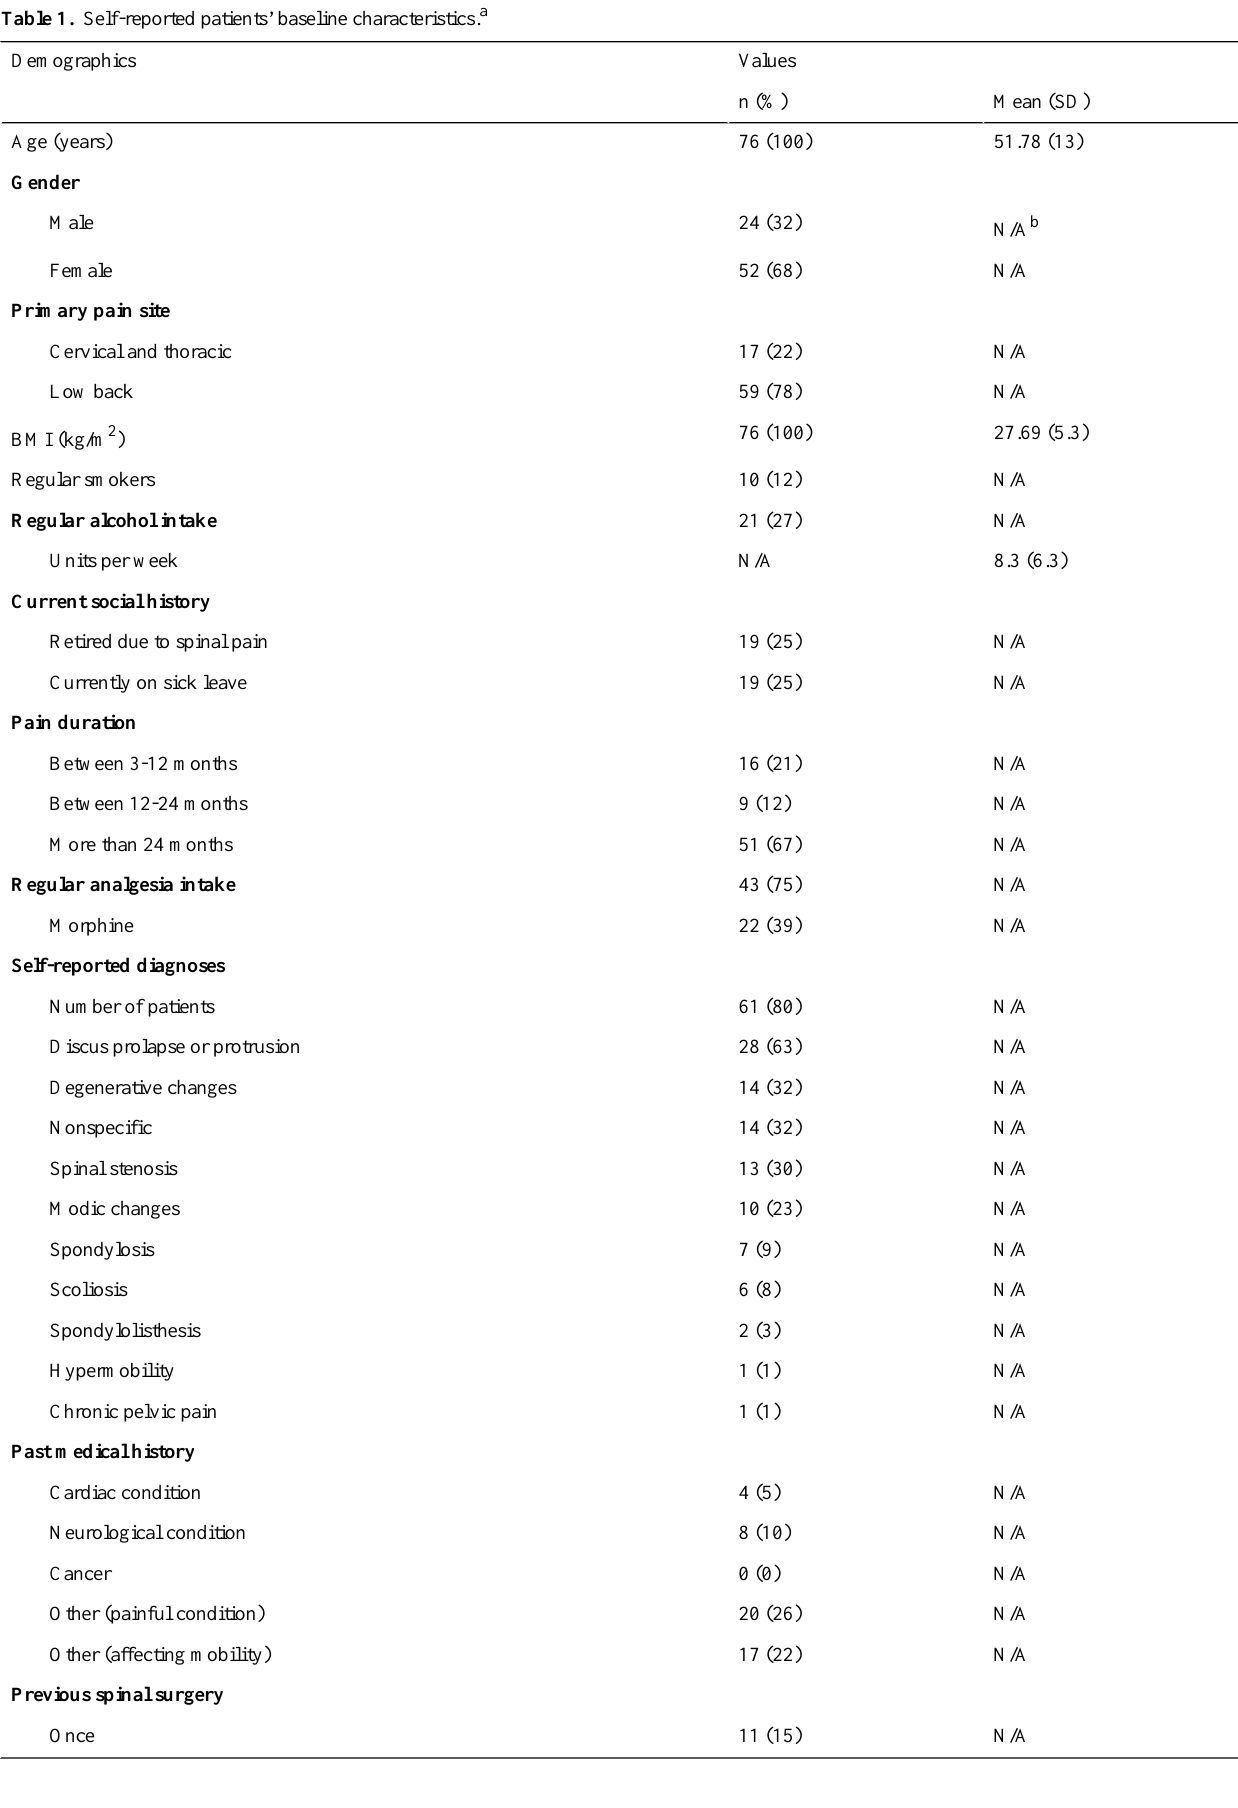
Table 1. Self-reported patients’baseline characteristics.